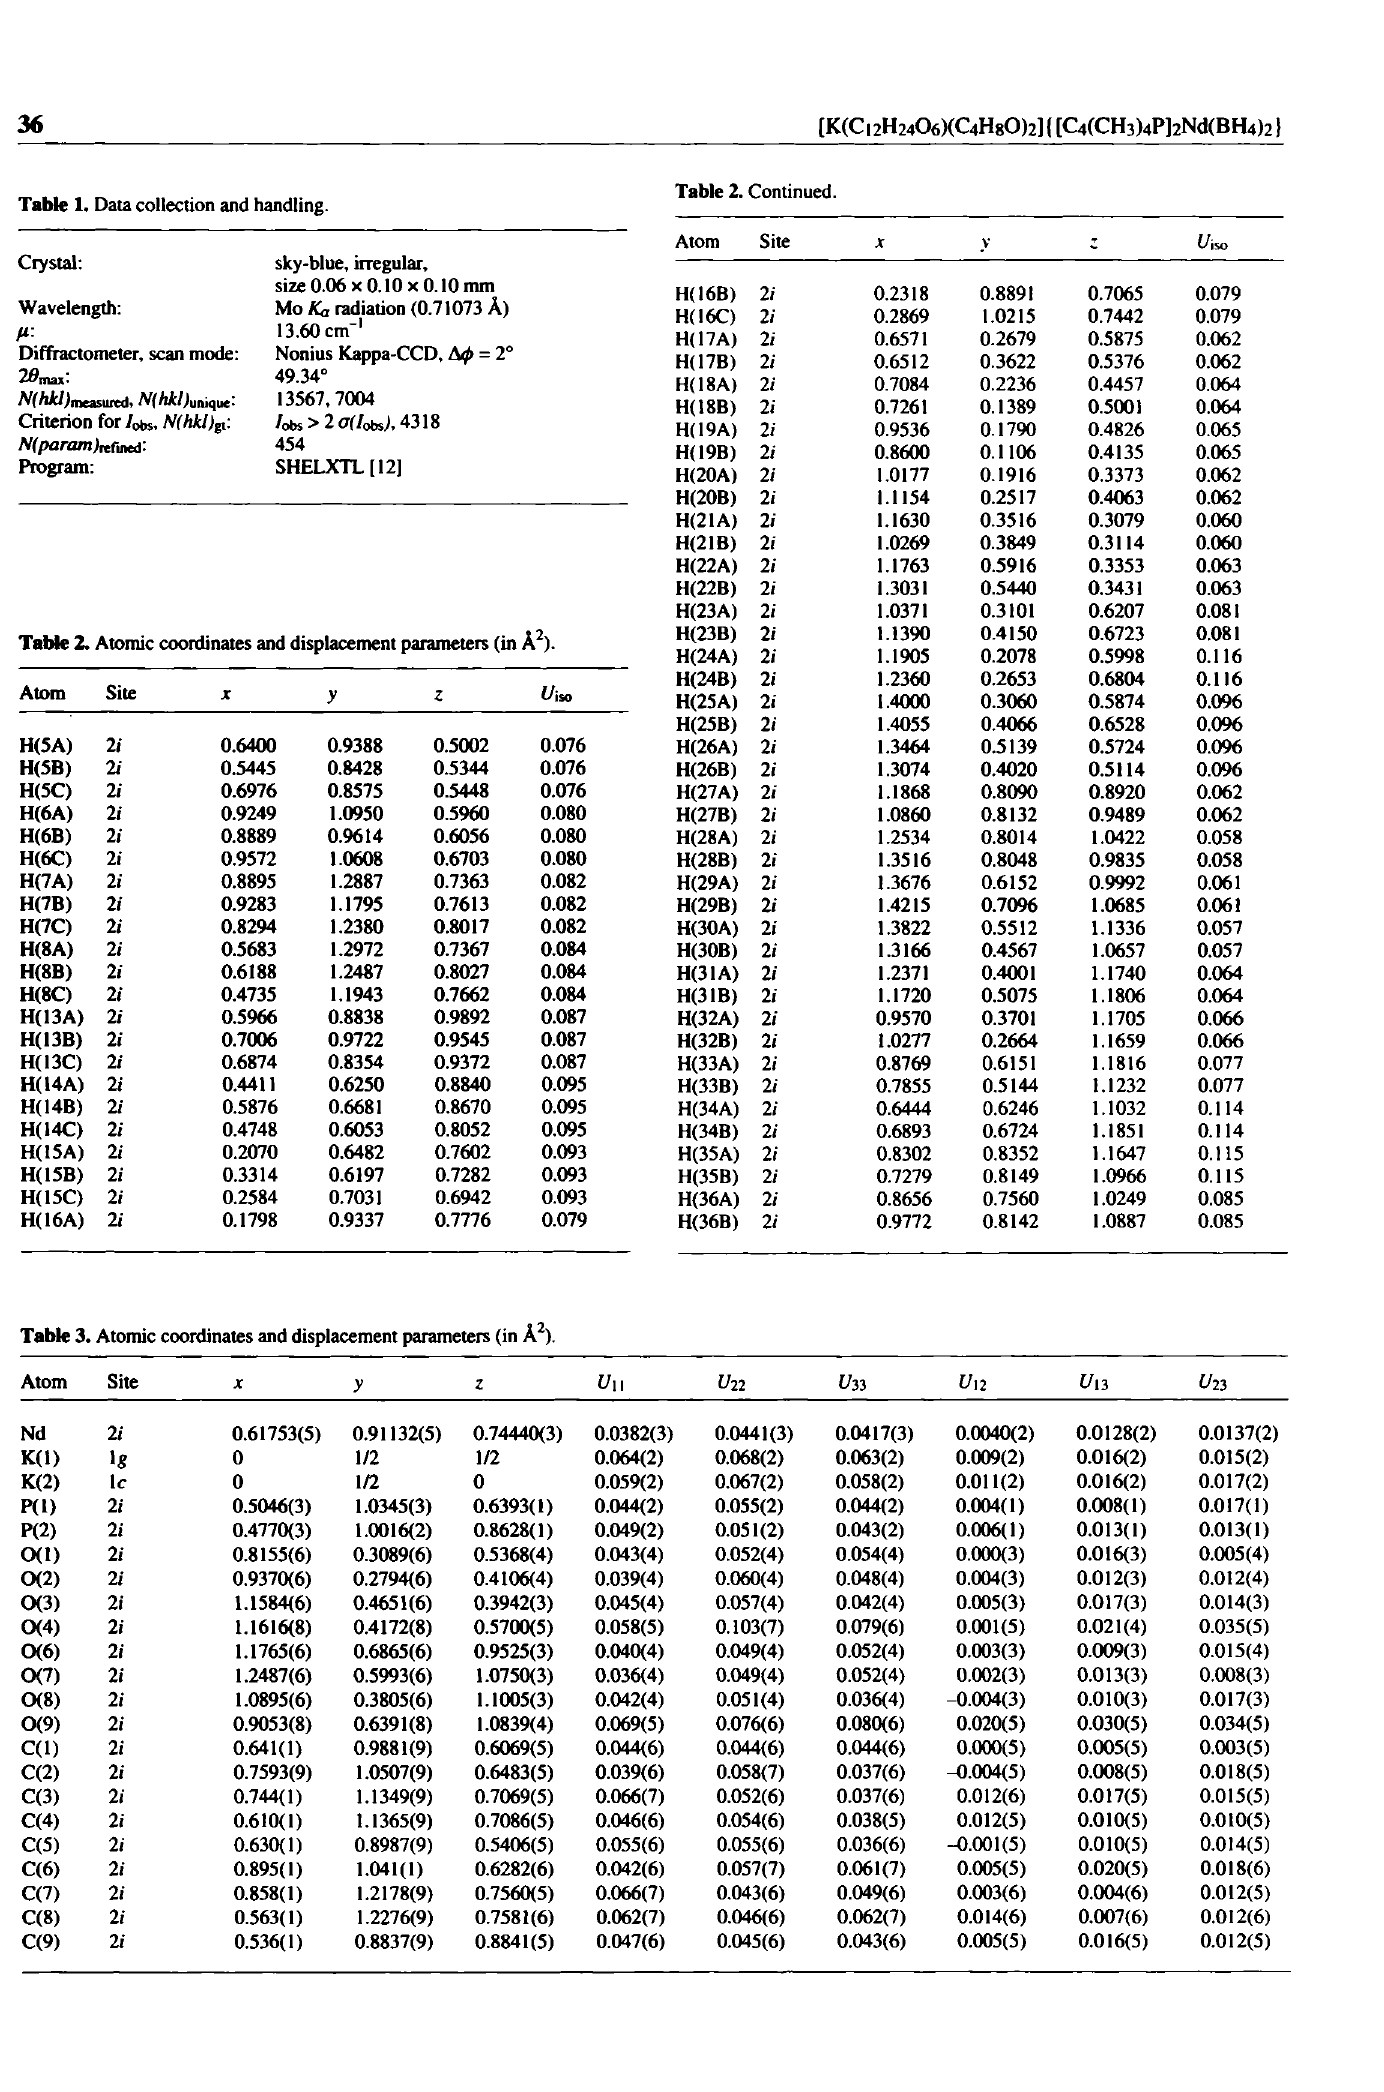
Table 1. Data collection and handling.